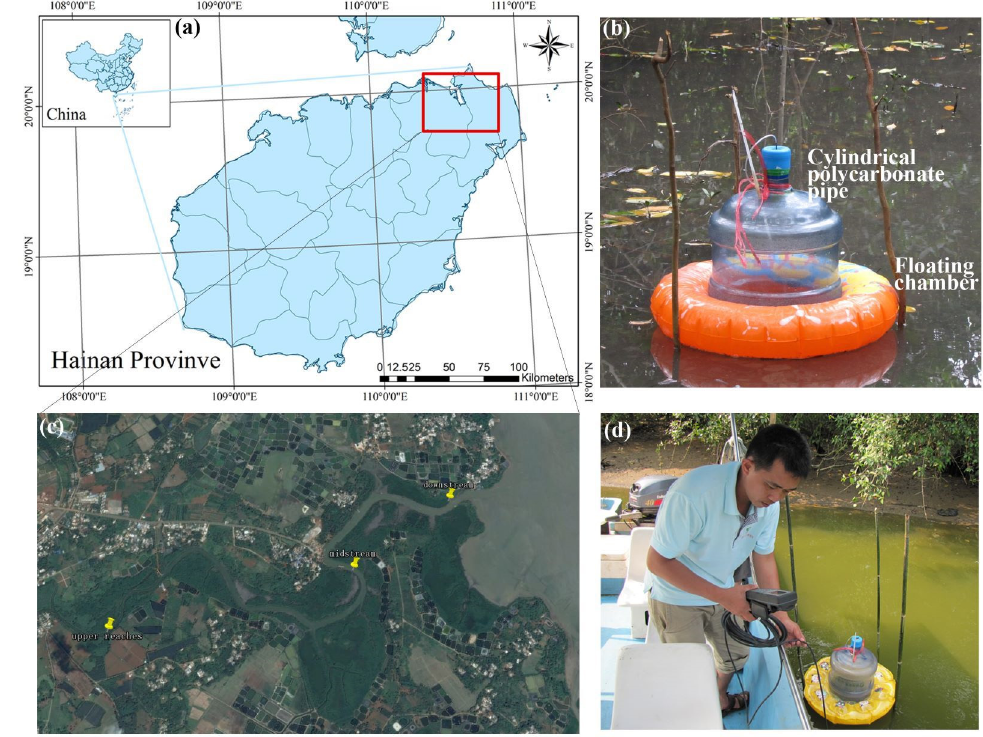
Figure 2. Sampling site—Dongzhaigang National Natural Reserve in Hainan Province ( a , b ) and CH 4 sampling device ( c ) and process ( d ) (( c , d ) were photographed by Wei Guan).